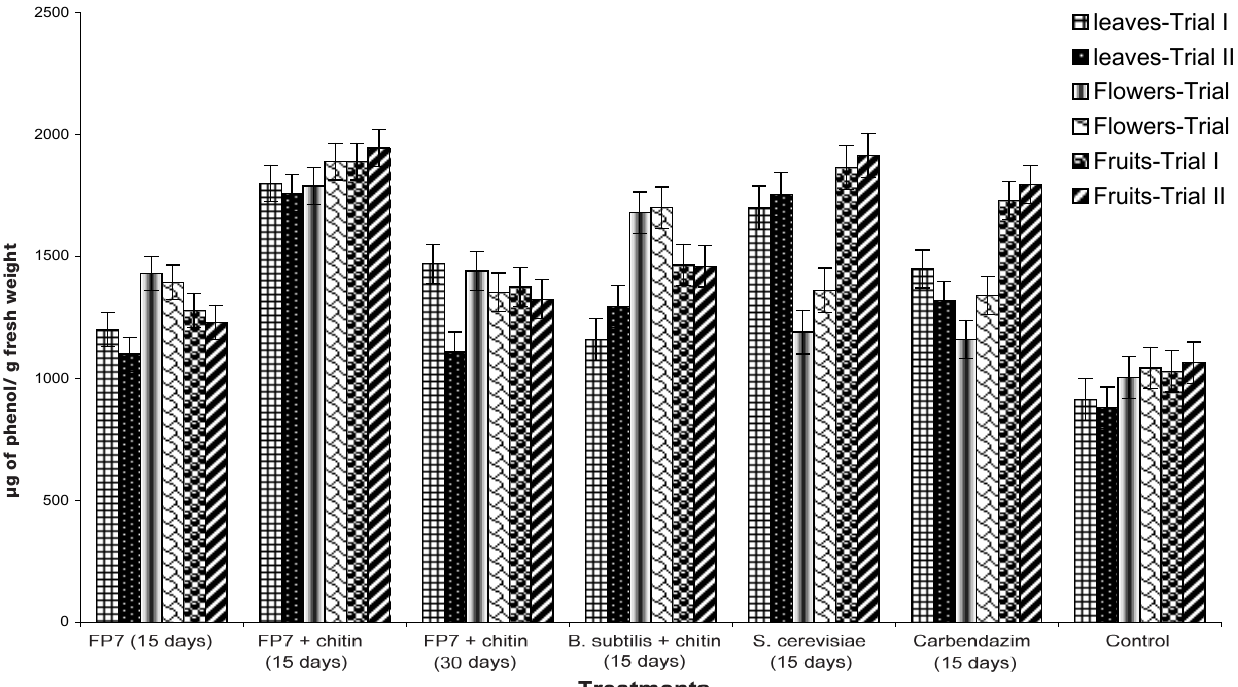
Fig. 5. Effect of pre-harvest application of biocontrol formulations on phenol accumulation in mango trees.